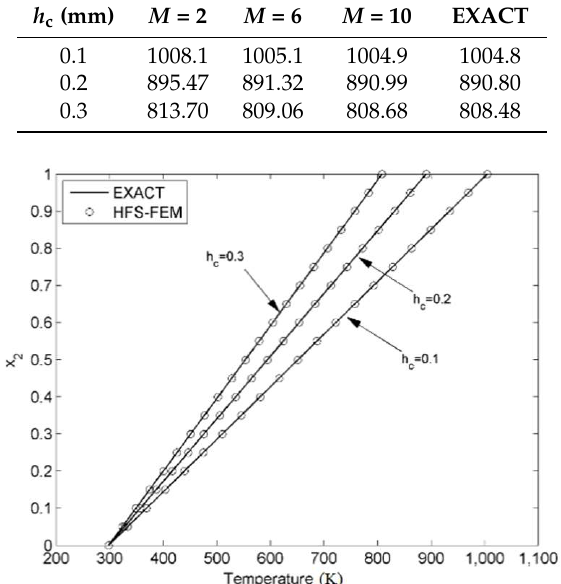
Table 6. Temperature at the interfacial point (0.5 mm, 1 mm) for different coating thicknesses for exponential gradation.